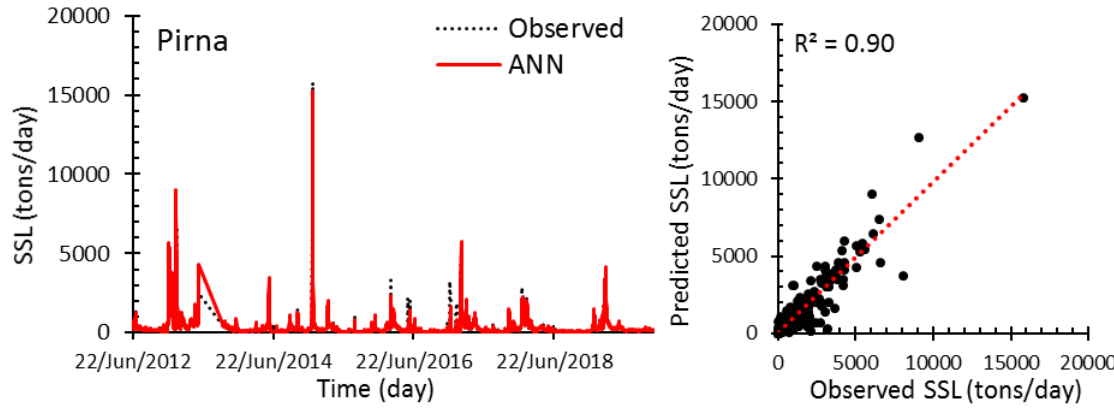
Figure 13. Observed versus predicted SSL of the best ANN model for the Pirna station in a testing phase.